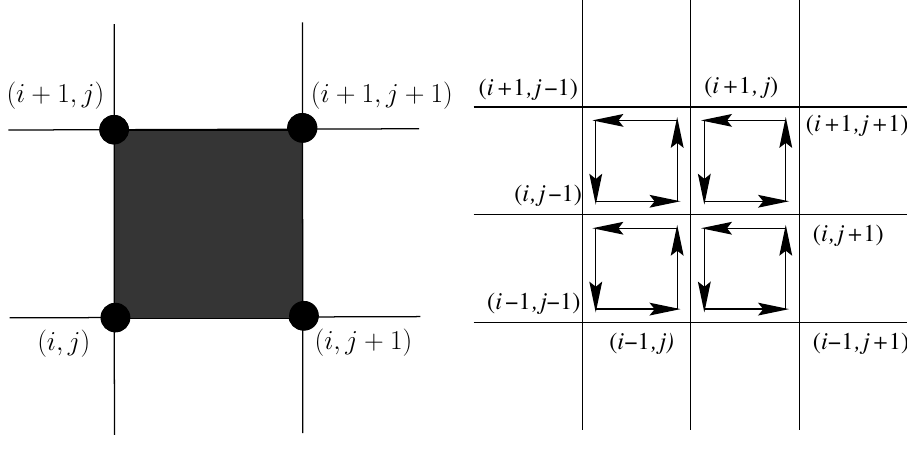
Fig. 5.4. On the left , the method based on rectangles; on the right , a possible method based on